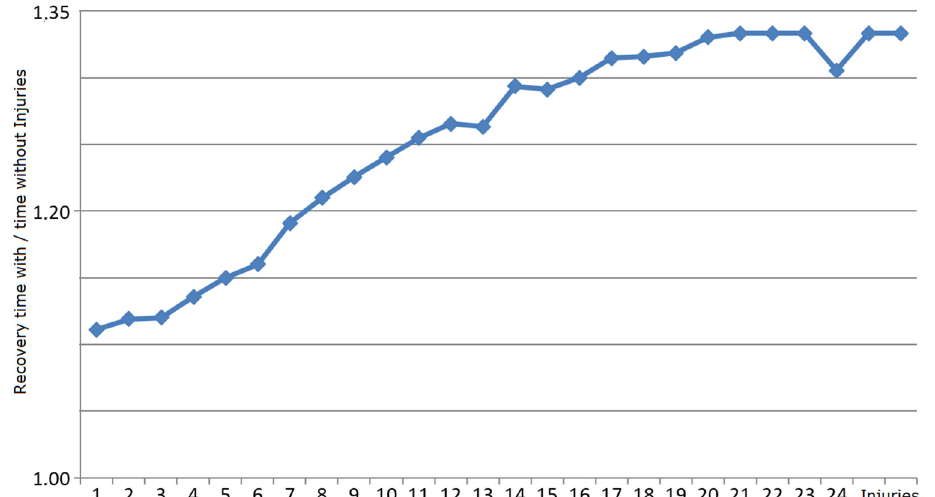
Figure 7. Relative time to recovery of M bac grown individuals. The x -axis shows the number of injuries (of any kind) and the y -axis shows the ratio of the recovery generation time relative to the normal generation time without injuries in order to reach adulthood. The y -values are averages over 100 runs in the experiment.